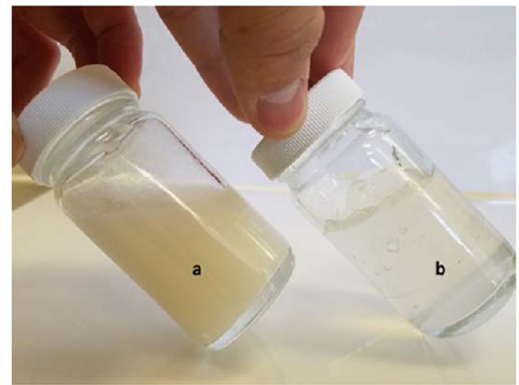
Figure 6: Change in transparency of CNF samples ( a ) before and ( b ) after ultrasonication. Adapted from ref. [ 53 ]